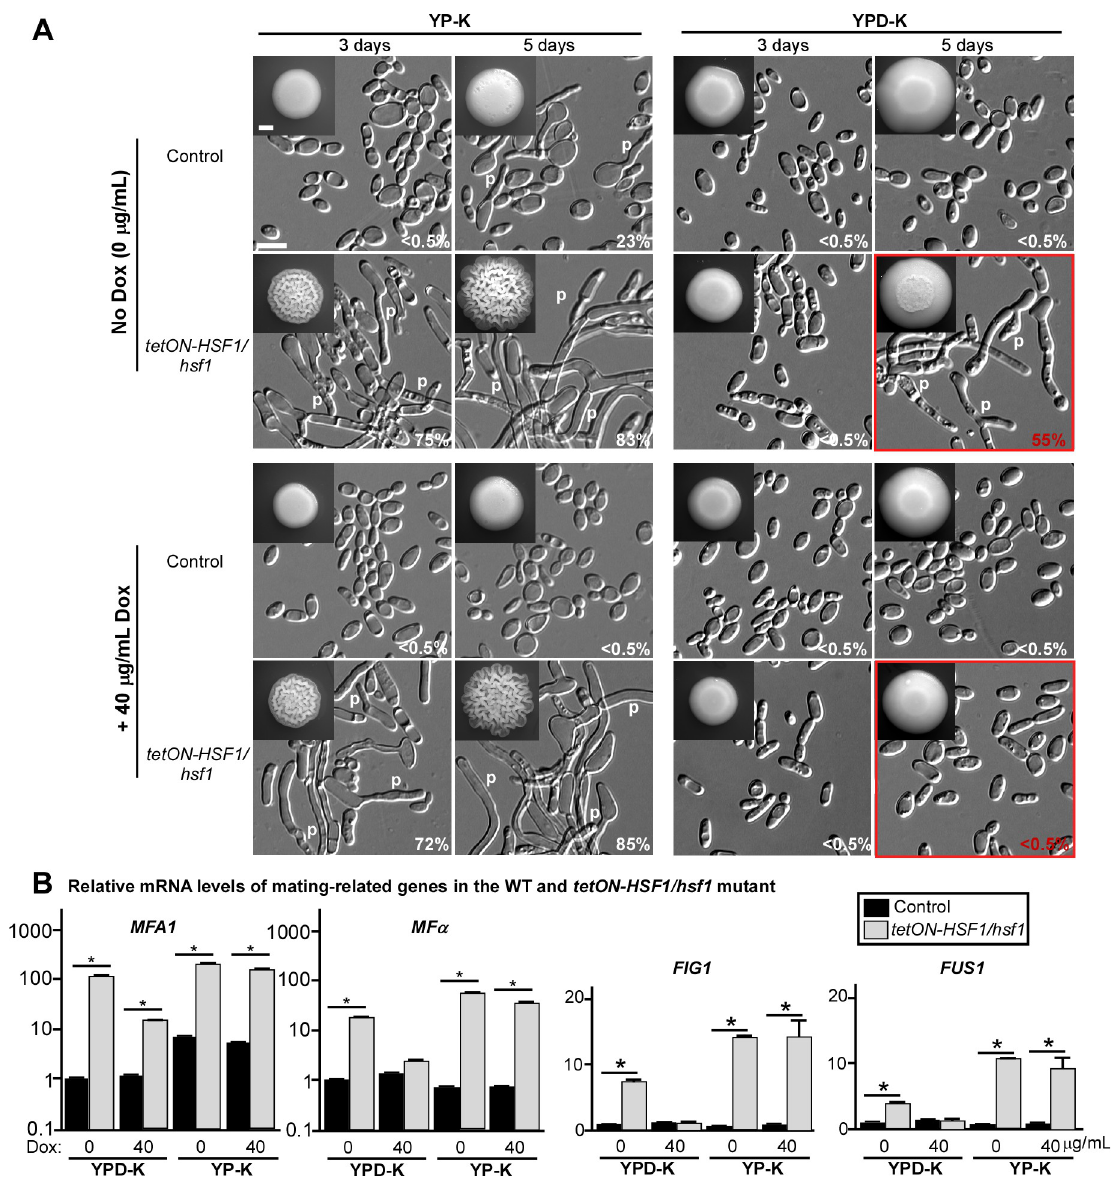
Fig 5. Role of Hsf1 in the induction of mating projections in C . albicans . (A) Morphologies of the control and tetON-HSF1/hsf1 mutant. 1 × 10 5 cells were spotted on YPD-K and YP-K media without or with 40 μ g/mL Dox and cultured at 25˚C for three or five days. Percentages of projected cells are indicated in the corresponding images. Scale bar for colonies, 2 mm (inset); scale bar for cells, 10 μ m. Control, GH1013cartTA. (B) Relative expression levels of mating-related genes. 1 × 10 5 cells of each strain were cultured on YPD-K medium (for six days) or on YP-K medium (for three days) without or with 40 μ g/mL Dox at 25˚C. Error bars represent standard errors of technical duplicates. � p < 0.05, two-tailed Student t test. Experiment was repeated in a biological replicate, and a representative image is shown. The numerical data are presented in S3 Data . Dox, doxycycline; FIG1 , Factor-Induced Gene 1; FUS1 , cell FUSion 1; Hsf1, Heat Shock transcription Factor 1; MFA1 , Mating type A1; MF α , Mating α factor precursor; p, mating projection; tetON , tetracycline-induced; tetON-HSF1/hsf1 , tetON -promoter–controlled conditional expression strain of HSF1 ; WT, wild type; YPD-K, yeast extract-peptone- glucose-K 2 HPO 4 ; YP-K, yeast extract-peptone-K 2 HPO 4